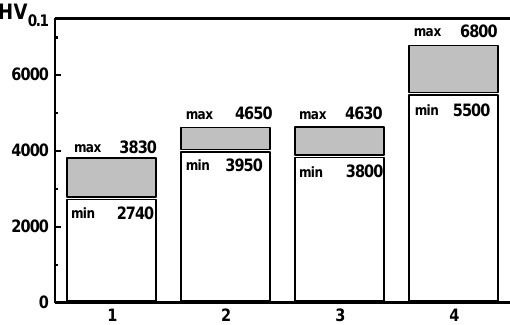
Fig.2. Microhardness of CEC Ni-B after the different thermal treatment parameters. (1) – without TT; after TT: (2) – 200  С; (3) – 300  С and (4) – 450  С. The minimum and maximum values of microhardness are given